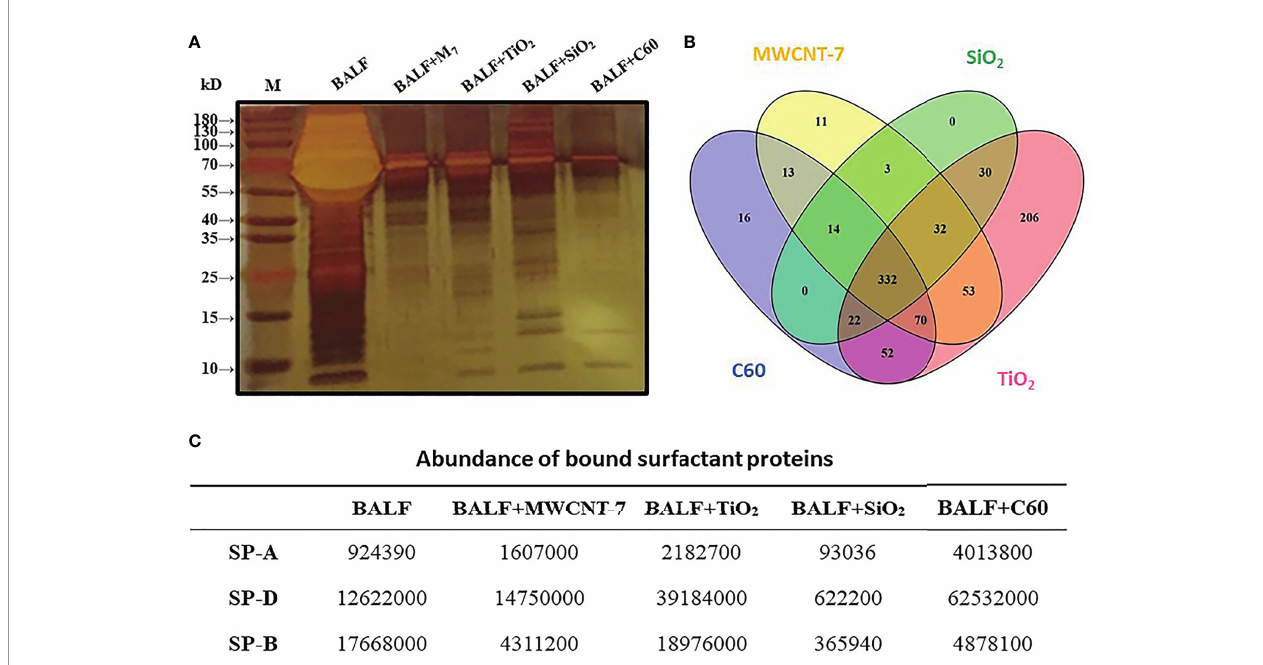
FIGURE 3 | Analysis of ENM-bound proteins. 800 m g of MWCNT-7, TiO 2 , SiO 2 , or C60 was incubated with 1 ml of 20-fold concentrated rat BALF at 37°C for 4-6 hr. The bound proteins were then disassociated from the ENMs and analyzed by SDS-PAGE and LC/MS. (A) imagine of SDS-PAGE; (B) Venn diagram showing the distribution of the proteins bound to the 4 ENMs; and (C) abundance of SP-A, SP-D, and SP-B bound to each type of